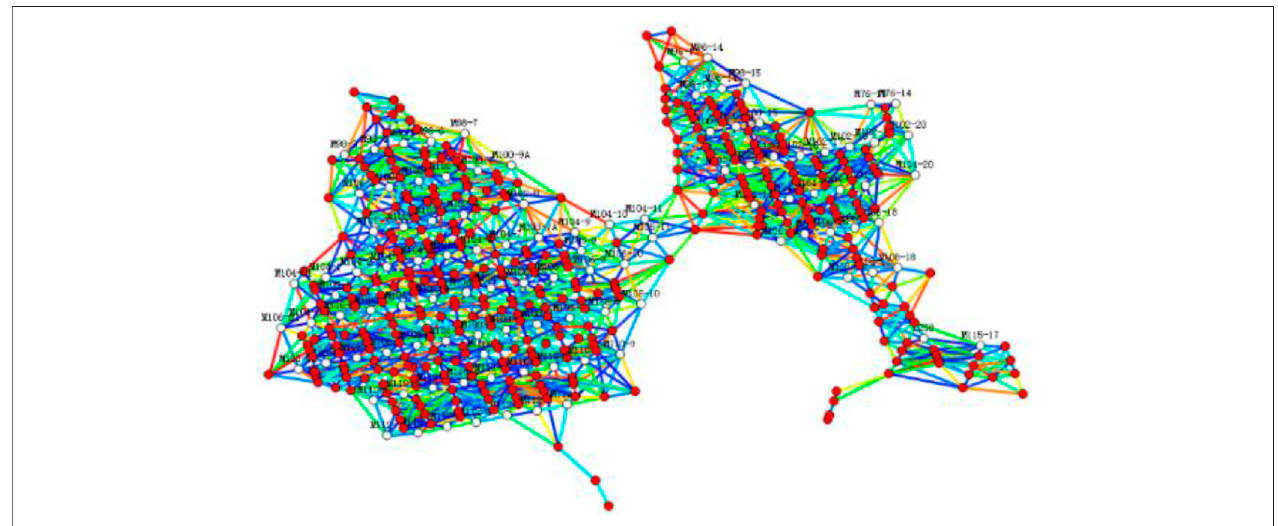
FIGURE 2 | Inversion of connected